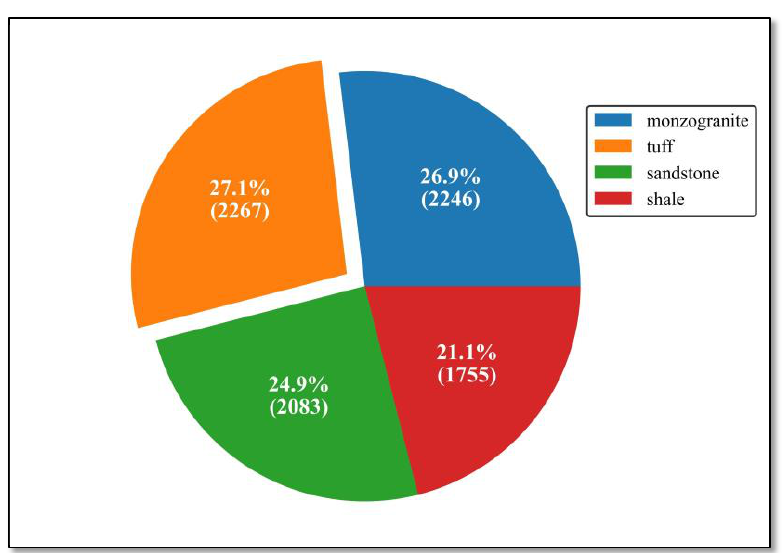
Figure 8. All types rock data distribution.